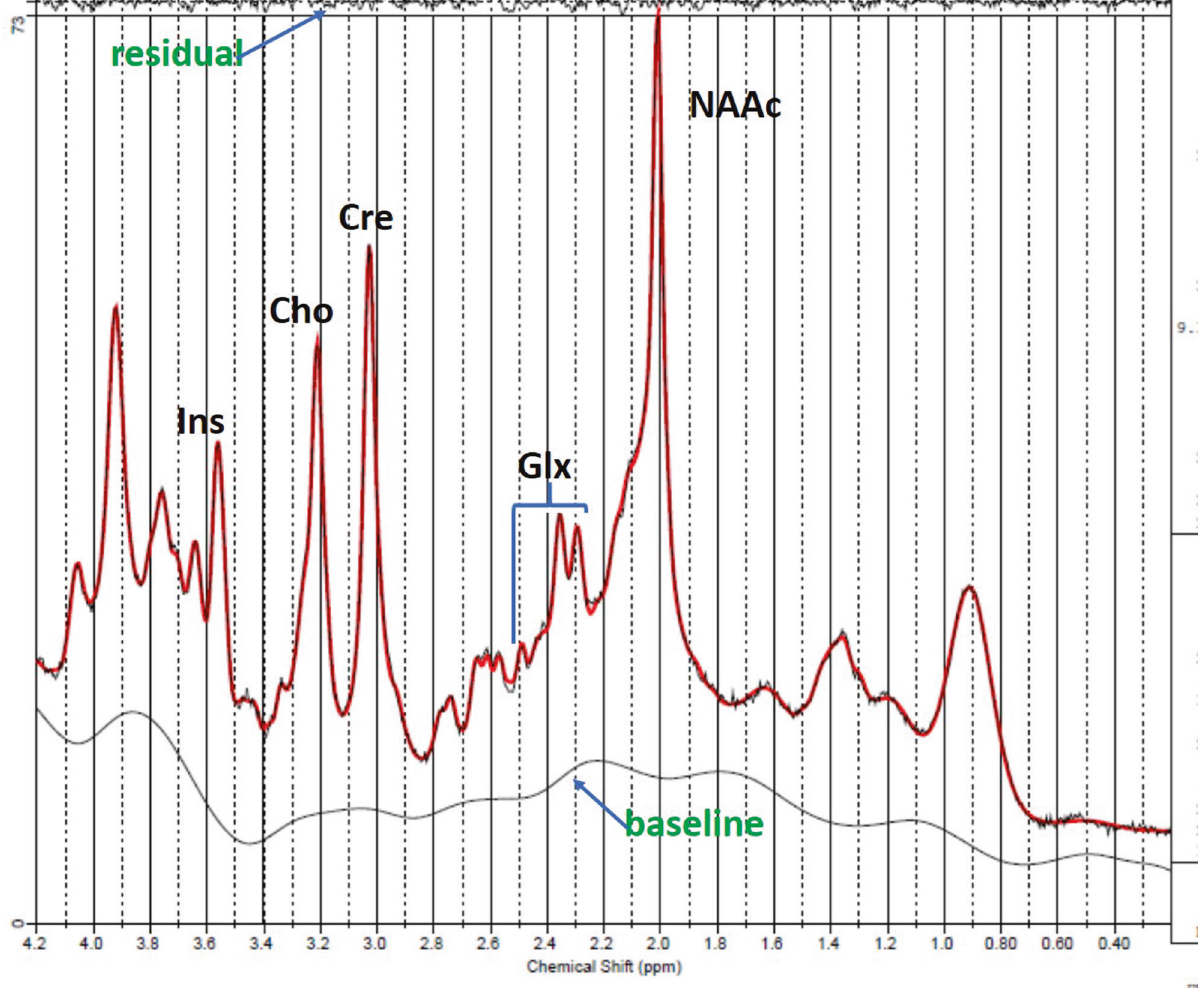
Fig. 2 Fitted 1 H-MRS spectrum (red) acquired from the dorsal anterior cingulate cortex in human. Glx (glutamate plus glutamine), NAAc (N-acetyl-aspartate compounds), Cre (creatine total), Cho (choline compounds), ins (inositol). Used VTE-PR STEAM (TR/TM/TE = 2000/10/6.5, VOI = 6 cm, NEX = 256, 2048 complex points; water scan, NEX = 16) in a Siemens 3T TIM Trio with a 32 channel head